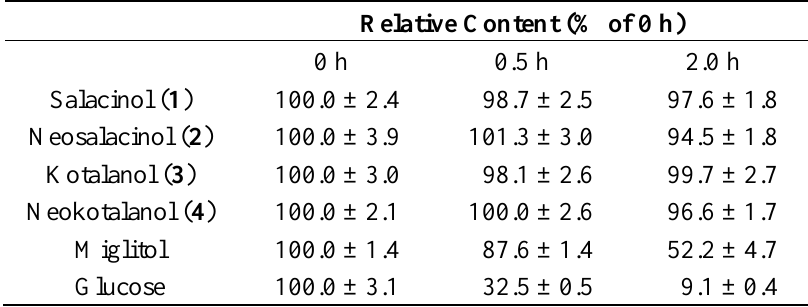
Table 8. Residual rate of sulfoniums ( 1 – 4 ) in ligated intestinal